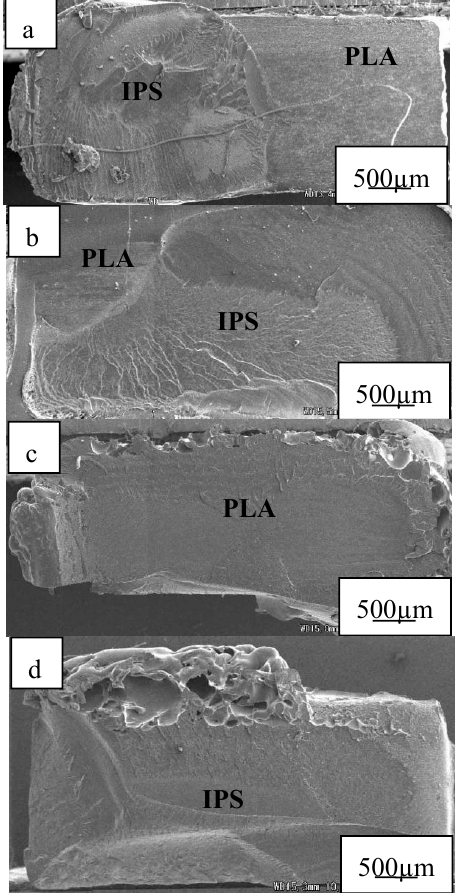
Figure 22. SEM images of rupture surfaces under welding pressure of 0.3 MPa and welding time of ( a ) 1 s, ( b ) 2 s, ( c ) 3 s and ( d ) 5 s. Adapted from Reference [151].